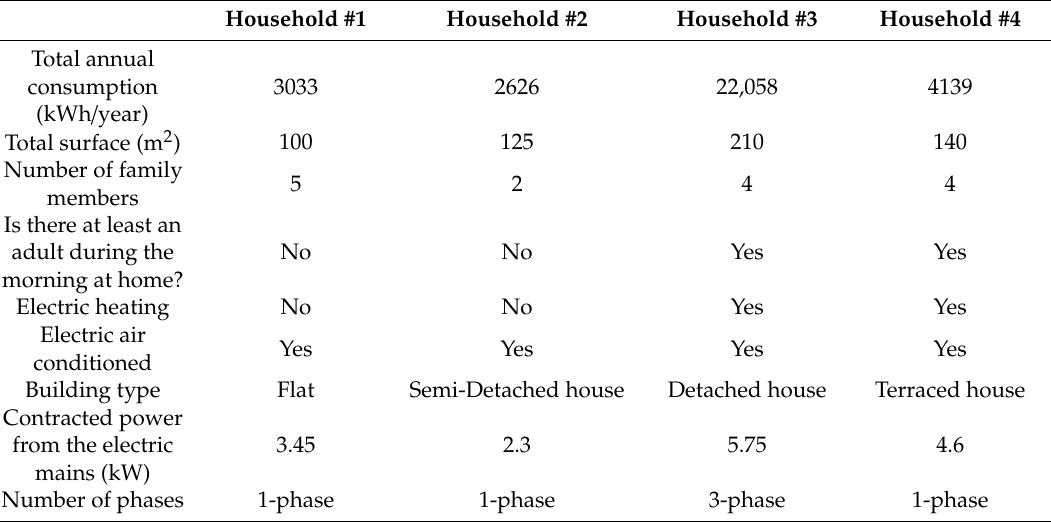
Table 2. Key features of four households in Ja é n (southern Spain). Case study.